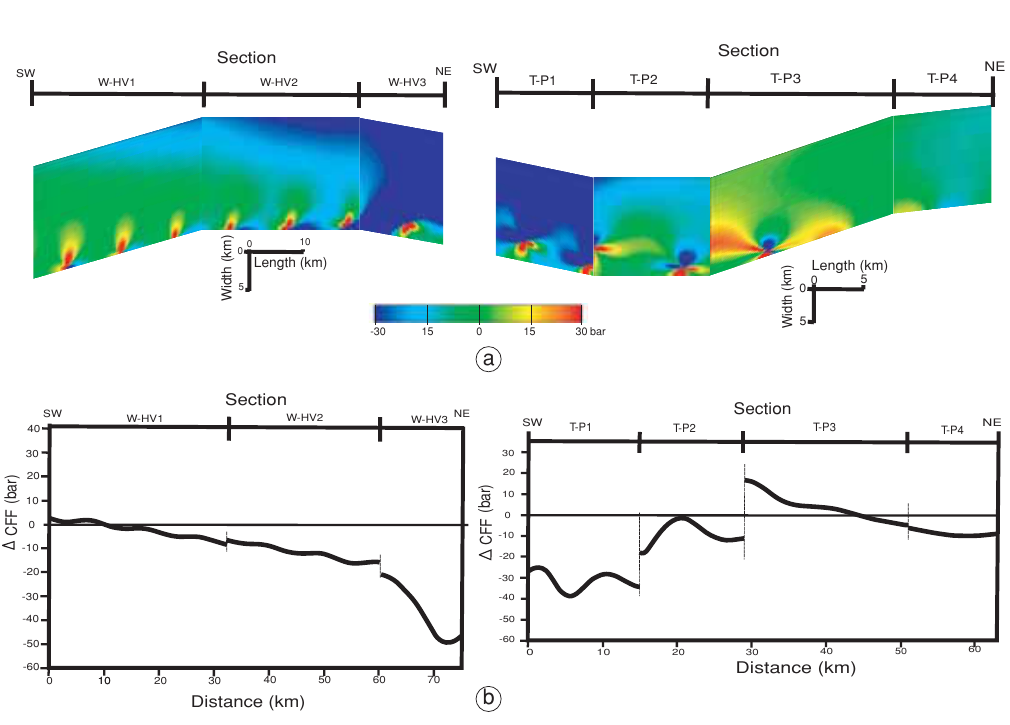
Fig. 7a,b. The distribution of (cid:54) CFSs for the tapered-displacement Wairarapa Fault. a) The distribution of (cid:54) CFSs on the fault planes of the W-HV and T-P segments. b) The distribution of (cid:54) CFSs at the mid-seismogenic depth of 10